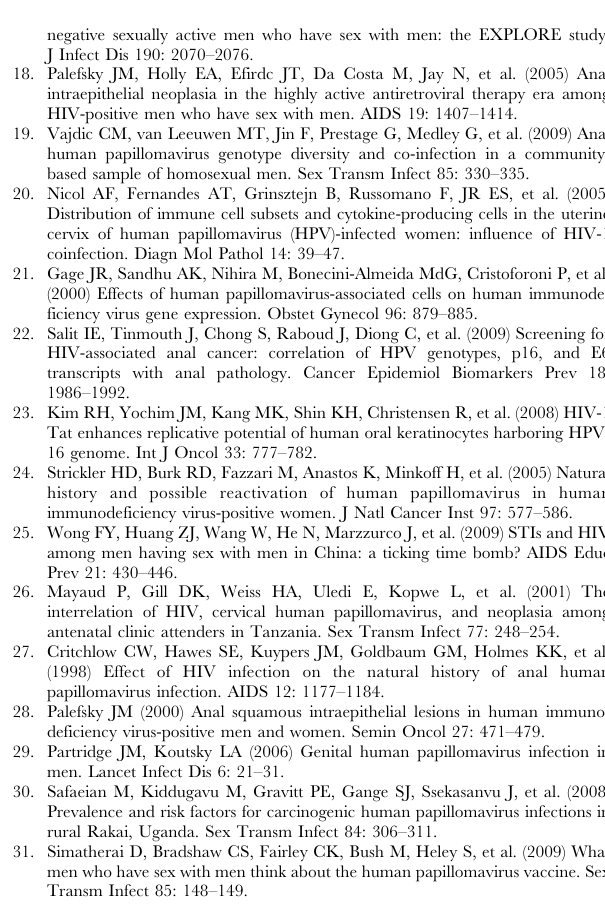
Table S4 Risk factors associated with prevalence of HIV-1 seropositivity (part